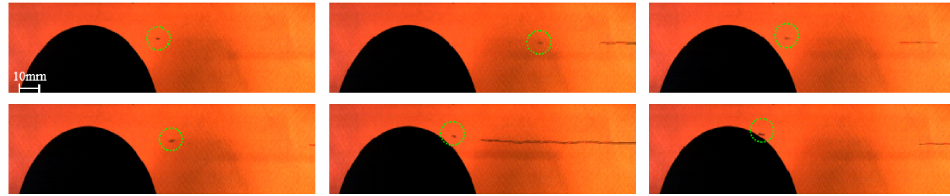
Figure 2. Inception of tip vortex cavitation NACA 16-020, α = 15 ◦ , σ = 2.97.